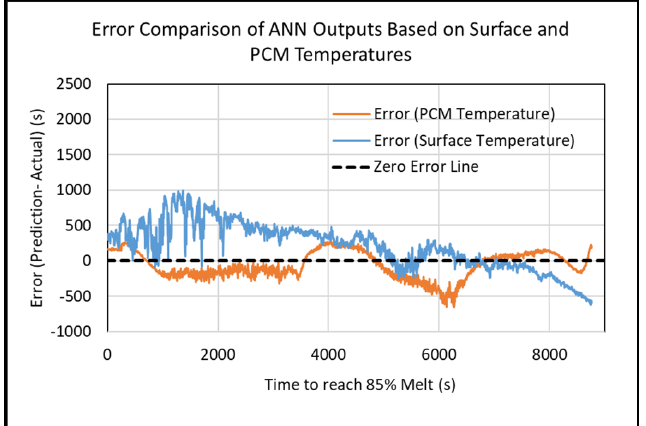
Figure 19. Comparison of error in predictions from the ANN model trained using transient surface- temperature data and transient PCM-temperature data (for test data set of 2.8 V and training data set of 2.6 V).